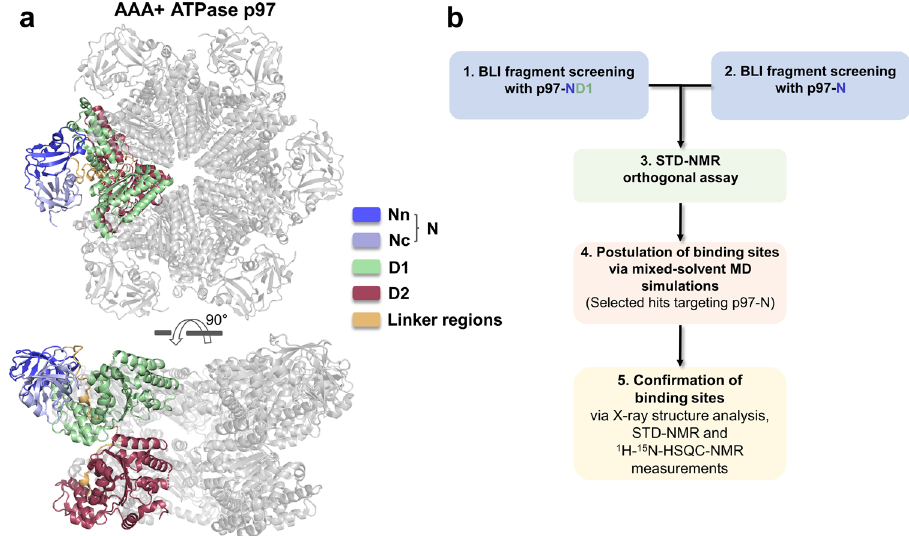
Fig. 1 Structure of p97 and work fl ow of the fragment screen. a Hexameric assembly of p97 (PDB entry: 5C1B) with one monomer shown in color. Each monomer can be divided into the two ATPase domains, D1 (green) and D2 (red), and an N-terminal domain consisting of two subdomains, Nn (blue) and Nc (light blue), where most of the known cofactors bind. The domains are connected by two linkers (orange). b Work fl ow of the fragment screen. To validate the screen, it was fi rst performed using a p97-ND1 construct. The established experimental conditions were transferred to the isolated N-domain, followed up by an orthogonal STD-NMR assay and the identi fi cation of the binding region of selected